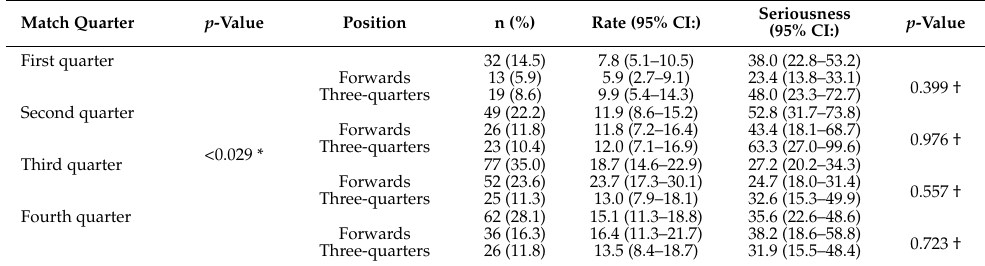
Table 7. Injuries by match quarter.